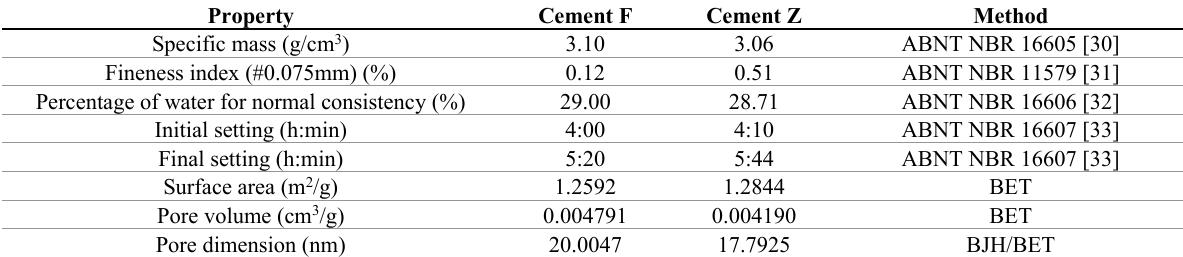
Table 1. Physical characteristics of cements CPII F-40 and CP II Z-32.